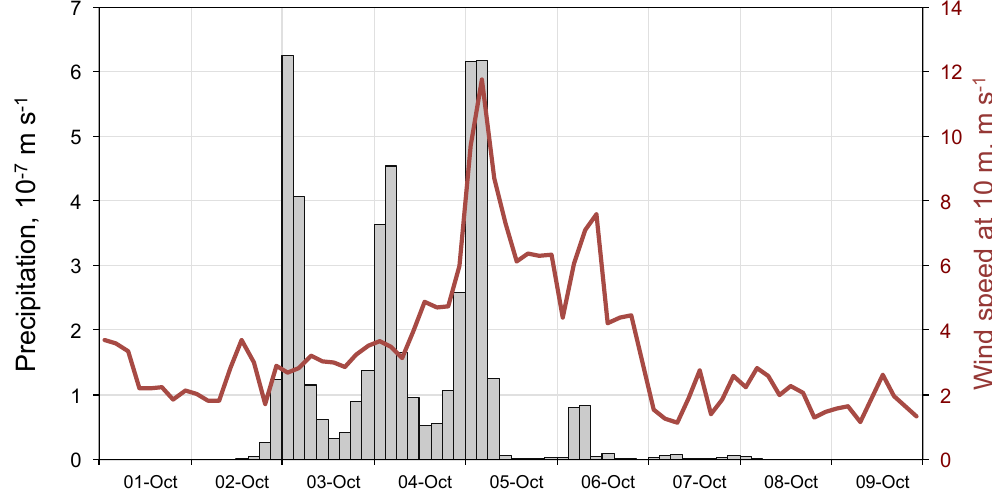
Figure 7. Area average precipitation and 10m wind magnitude during the cruise period from a limited area high resolution weather forecast- ing model of the Mediterranean Sea (Bonavita et al., 2008). Precipitation is visualized as an histogram (units of ms − 1 ) and wind magnitude is the red curve (units of ms − 1